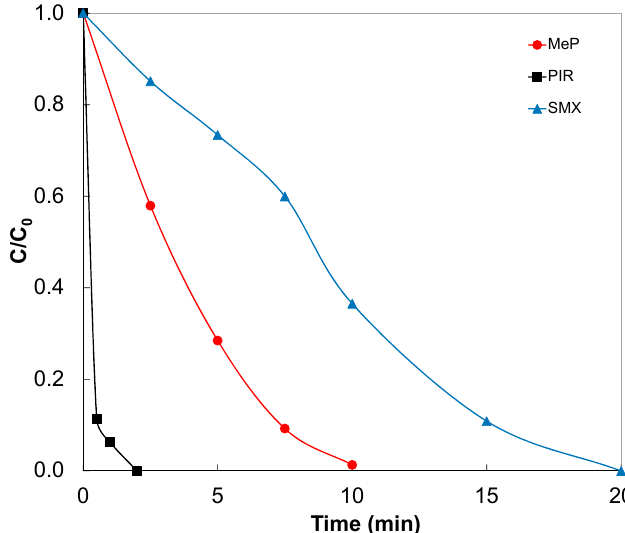
Figure 5. E ff ect of type of micropollutant on degradation e ffi ciency of methyl paraben (MeP), piroxicam Figure 5. Effect of type of micropollutant on degradation efficiency of methyl paraben (MeP),